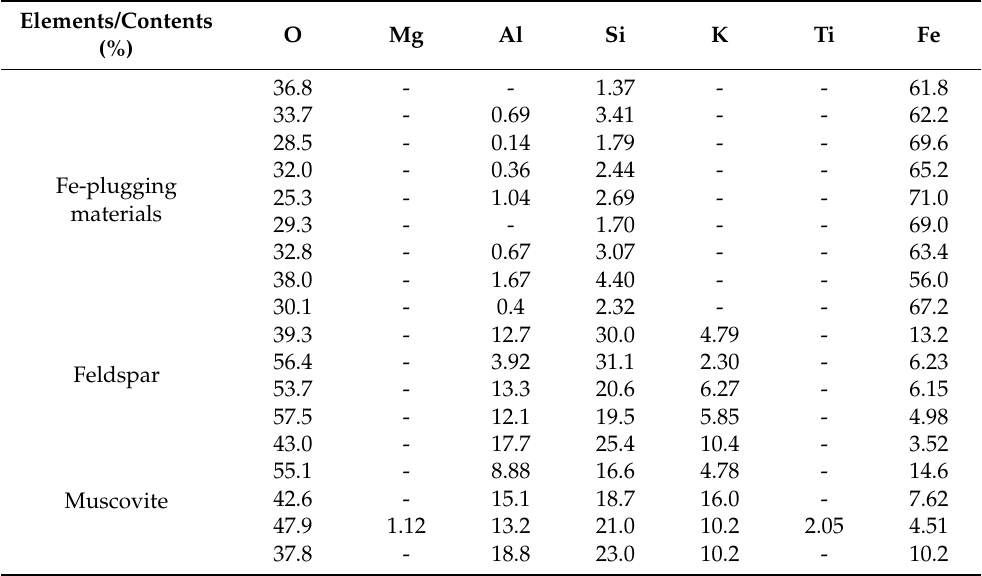
Table 4. EDS data for Fe-plugging materials, feldspar, and muscovite in plugged